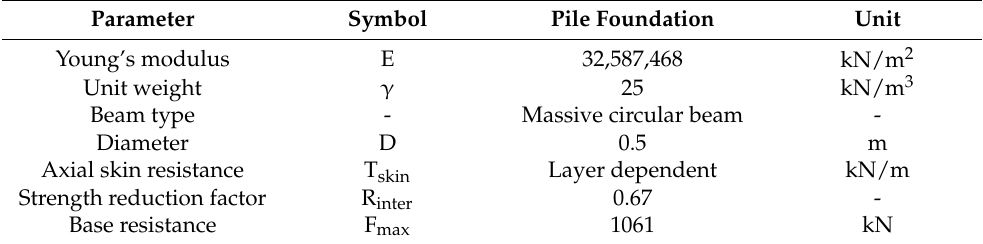
Table 5. Material properties of embedded